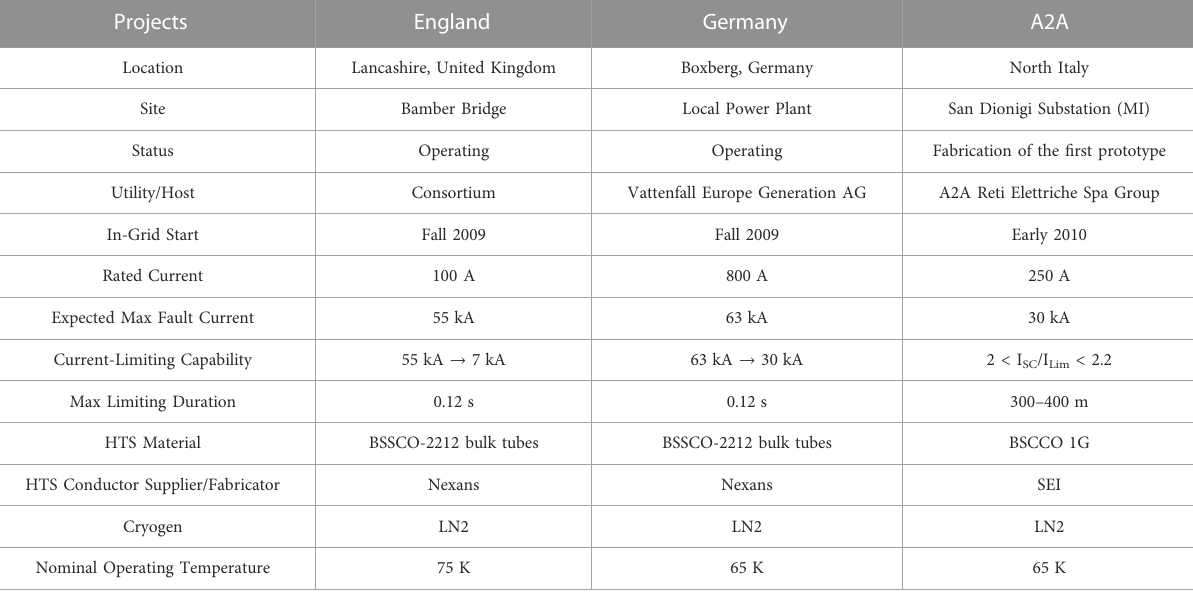
TABLE 2 Resistive SFCL Demonstration Projects [Electric Power Research Institute (EPRI), 2009], (Martini et al.,